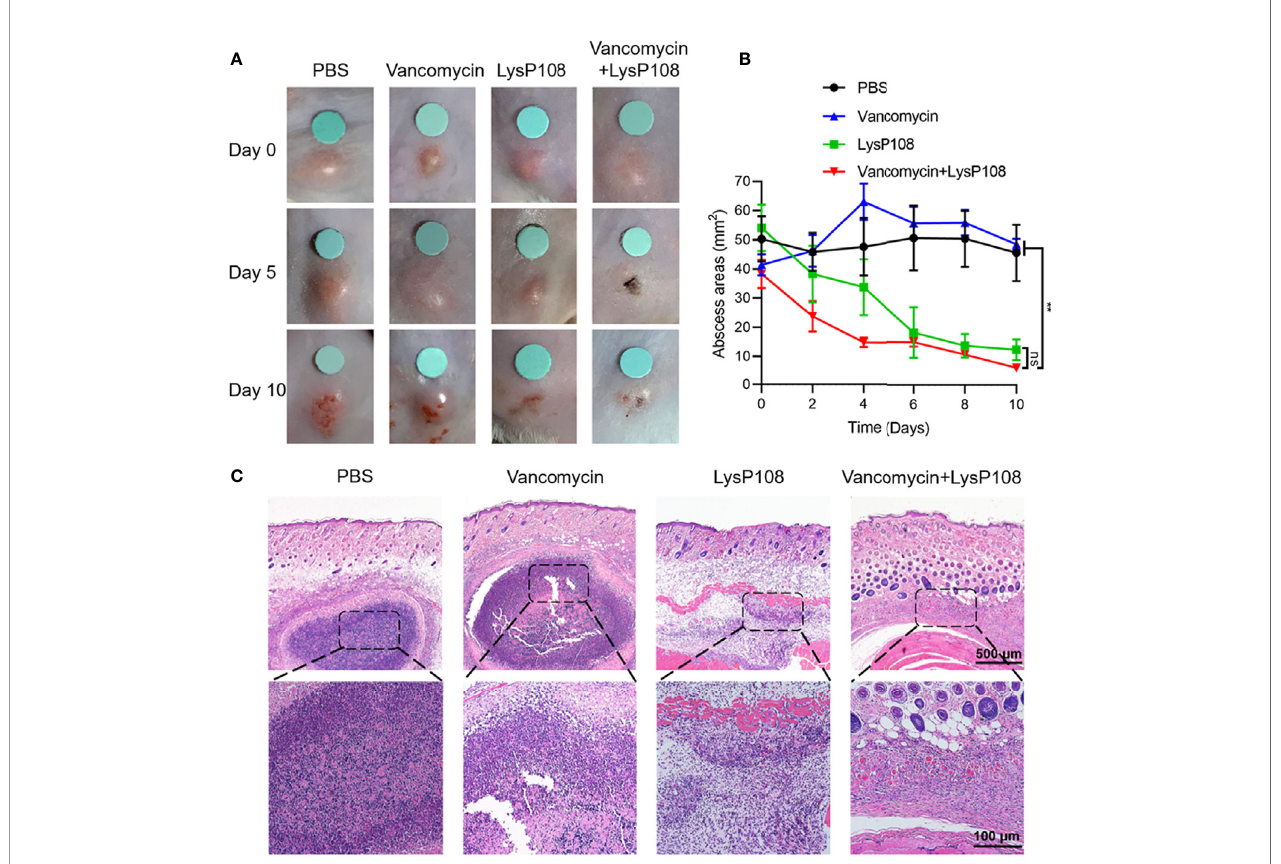
FIGURE 8 | Synergistic antibacterial effect of LysP108 and vancomycin in vivo . (A) Photographs of endolysin combined with vancomycin for the treatment of mice subcutaneous abscess. (B) Subcutaneous abscess area curve of MRSA infected on the back of mice. (n=6). (C) Representative H&E staining images of infected skin subjected to various treatments. The violet circles indicate the subcutaneous abscess. Scale bar: 100 m m. ** P < 0.01; ns, not signi fi